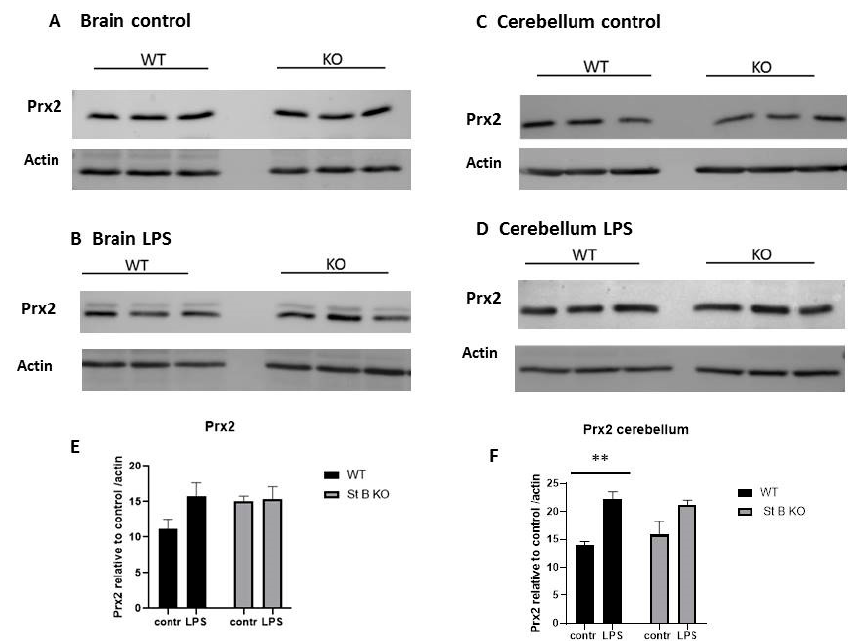
Figure 3. Prx2 in the brain and cerebellar tissue from stefin B deficient (KO) and control (WT) mice after LPS application. Age-matched control FVB/N mice (WT) and stefin B-deficient (KO) (n = 6) were left untreated or were injected with LPS (3 mg/kg body weight). 4 h after LPS challenge, animals were sacrificed. Brain tissue lysates ( A ) and cerebellar tissue lysates ( C ) from control mice or LPS injected animals ( B , D ) were analyzed by Western blots with antibodies against Prx2. Anti β -actin antibodies were used as loading controls. The levels of Prx2 in brain lysates ( E ), and Prx2 in cerebellar lysates ( F ) from wild type (WT) and stefin B-deficient (KO) mice in comparison to β -actin controls were quantified by ImageJ. Statistically significant differences vs. control group, * p < 0.05. ** p ≤ 0.01.